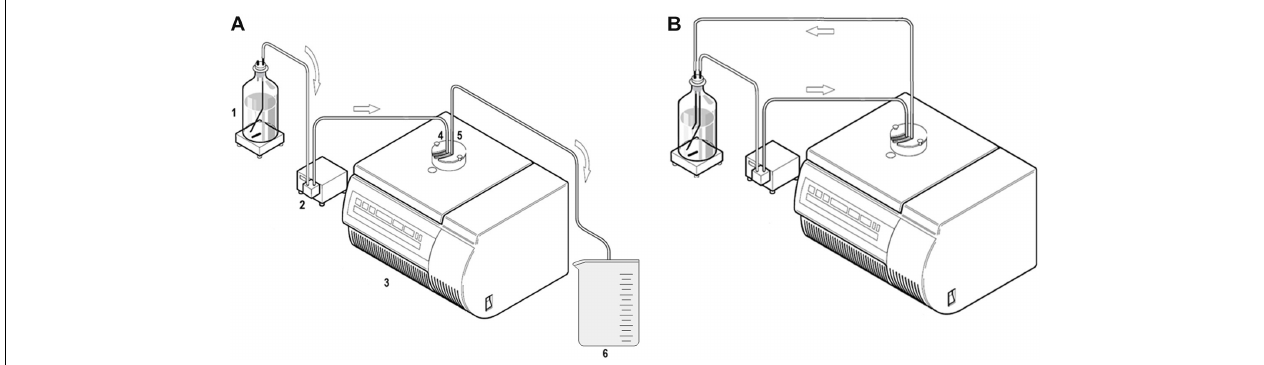
FIGURE 1 | Schematic drawing of the experimental setup for CFC. (A) : Linear setup (1: Suspension bottle containing the NPPs on a magnetic stirrer. 2: Peristaltic pump. 3: Flow Centrifuge. 4: Inflow. 5: Outflow. 6: Collected effluent fraction). (B) Circular setup (Heraeus Instruments GmbH, 1998, modified) © Thermo Scientific.